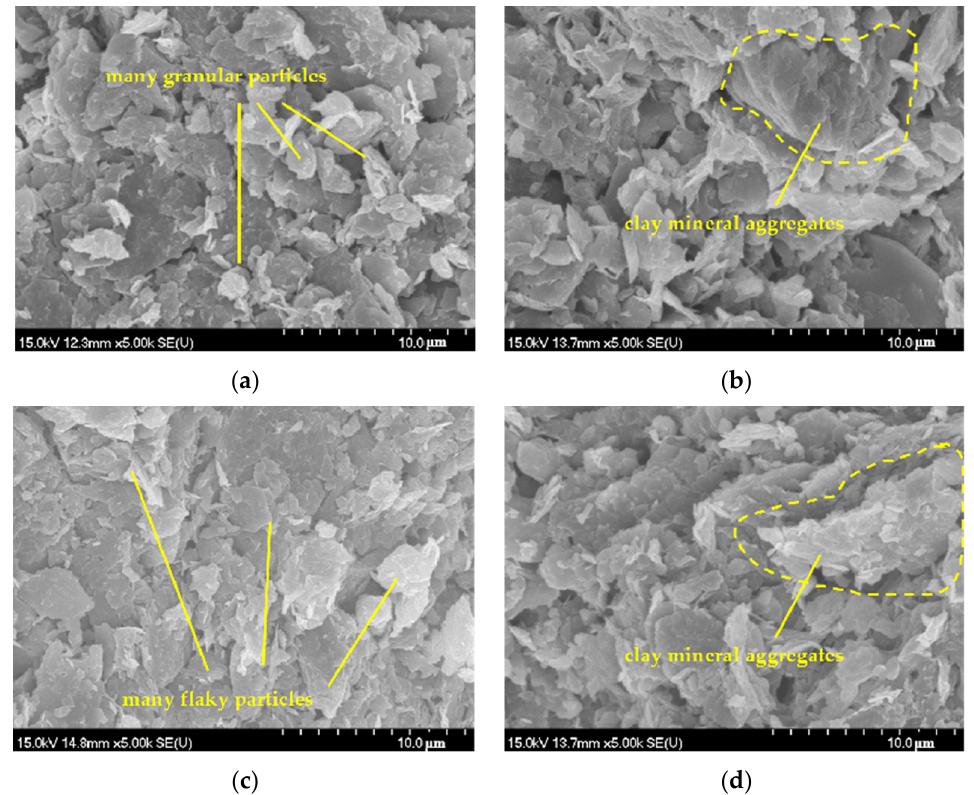
Figure 10. Microstructure of the four types of stabilized slurry with a 1% lime dosage. ( a ) Wenzhou soil sample, ( b ) Hangzhou soil sample, ( c ) Taizhou soil sample, ( d ) Zhoushan soil sample.